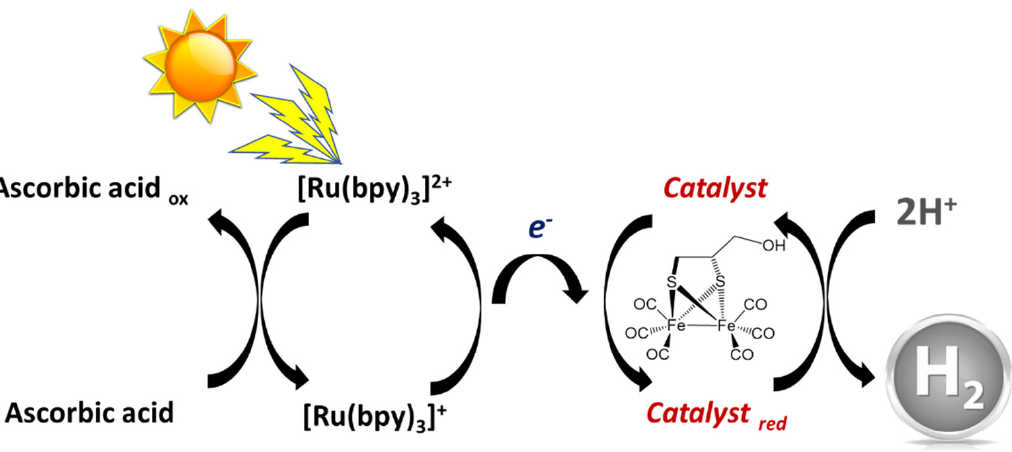
Figure 7. Schematic representation of light-driven hydrogen production by the FeFeOH catalyst.